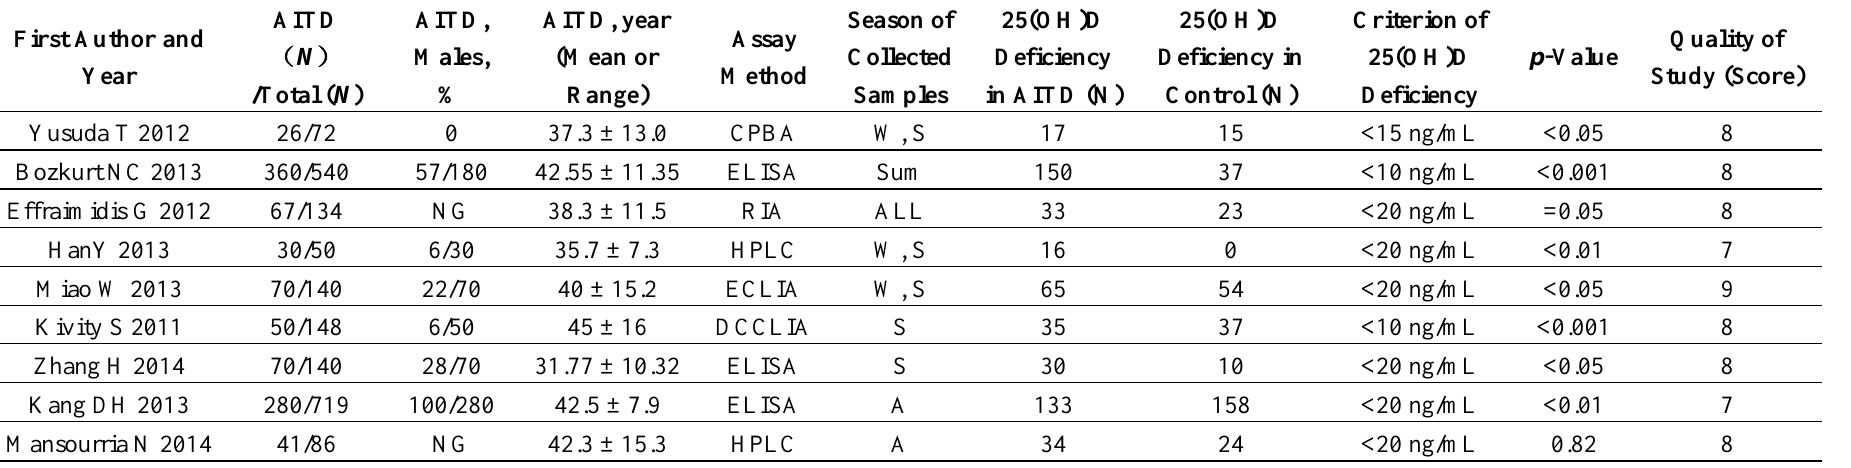
(Introductions of Table 2: (1) Assay method: ELISA, enzyme-linked immunosorbent assay; HPLC, high performance liquid chromatography; ECLIA, chemiluminescence immunoassay; CPBA, competitive protein binding assay; DCCLIA, direct competitive chemiluminescence immunoassay; RIA, radioimmunoassay. (2) Season: S, spring; Sum, summer; A, autumn; W, winter. (3) N , number; NG, not given; NS, not